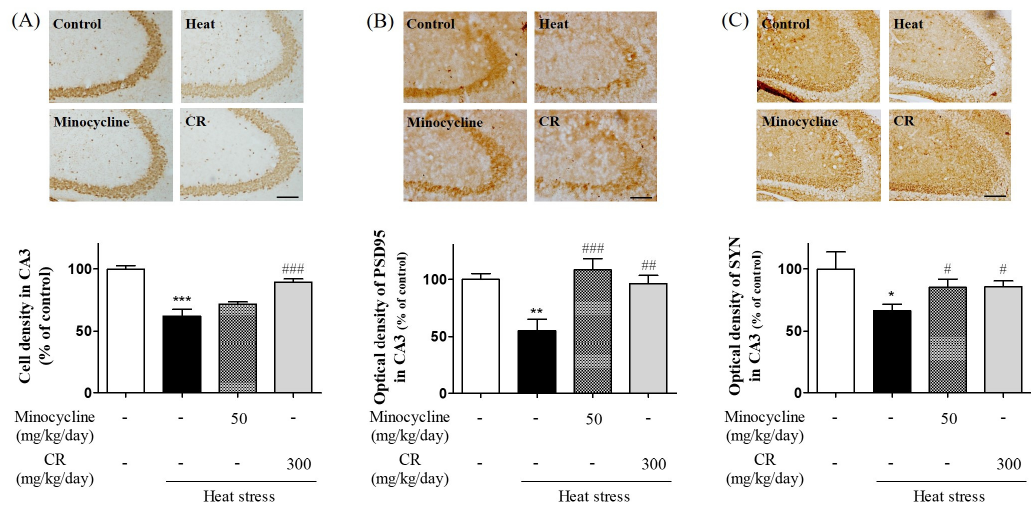
Figure 7. Inhibitory effects of CR on heat stress-induced neurodegeneration in hippocampus of mice. ( A ) The effect of CR (300 mg/kg) on neuronal loss was determined using NeuN immunostaining. ( B , C ) The effect of CR (300 mg/kg) on synaptic function was measured with PSD-95 and synaptophysin immunostaining. ( B ) Representative pictures of PSD-95 staining are shown. ( C ) Representative pictures of synaptophysin staining are shown. Scale bar = 50 µ m. The minocycline (50 mg/kg), an anti-inflammatory drug, was used as positive control. Values are expressed as means ± SEM. * p < 0.05, ** p < 0.01 and *** p < 0.001 as compared with the control group. # p < 0.05, ## p < 0.01 and ### p <